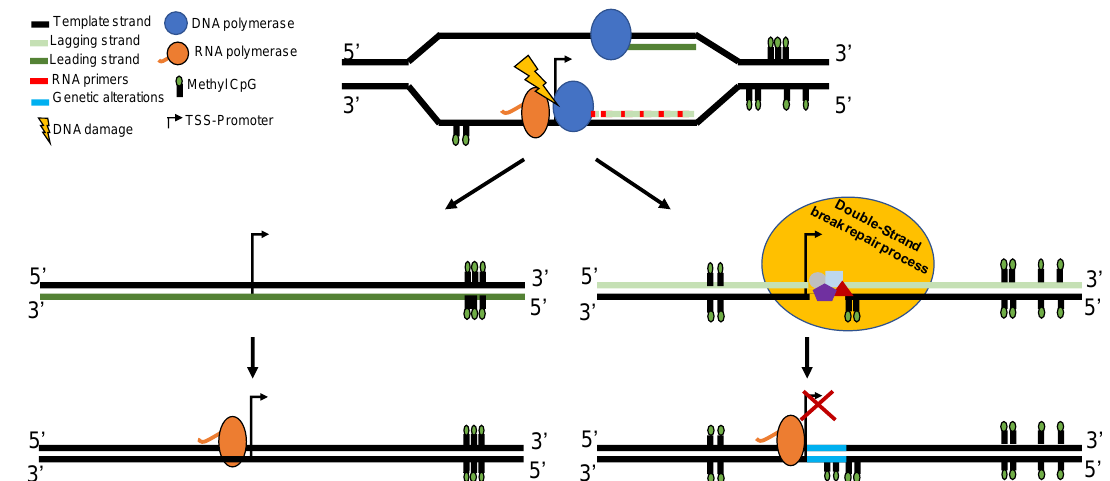
Figure 4. Graphical abstract. DNA damage caused by DNA and RNA polymerases collisions and DNA repair (Figure 2) are associated with de novo methylation of the repaired DNA segment (Figure 3). Inhibition of replication or transcription significantly reduces the damage and CpG methylation of the region (Figure 3). De novo methylation of the promoter regions reduces the expression of the suppressor genes, and ultimately removes the barrier to oncogene-induced senescence.